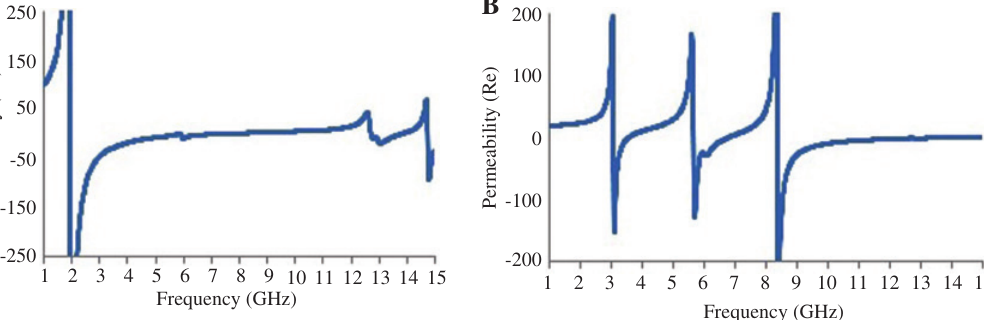
Figure 9: (A) Real value of effective permittivity versus frequency and (B) real value of effective permeability versus frequency for the y -axis wave propagation.